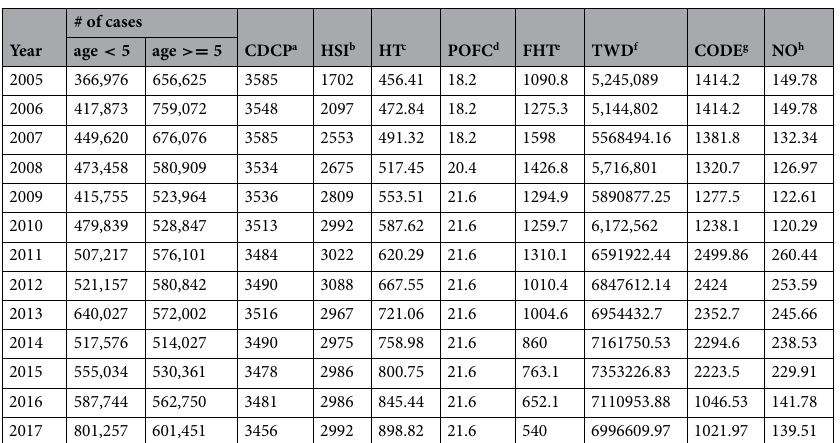
Table 1. Yearly data of number of infectious diarrhea cases in two age groups, as well as the social factors. a The quantity of centers for disease control and prevention. b The quantity of health supervision institute. c The quantity of health technicians (10,000). d The forest coverage rate (%). e The weight of fecal harmful treatment (10,000 tons). f The amounts of wastewater discharge (10,000 tons). g Chemical oxygen demand emissions (10,000 tons). h Nitrogen output (10000